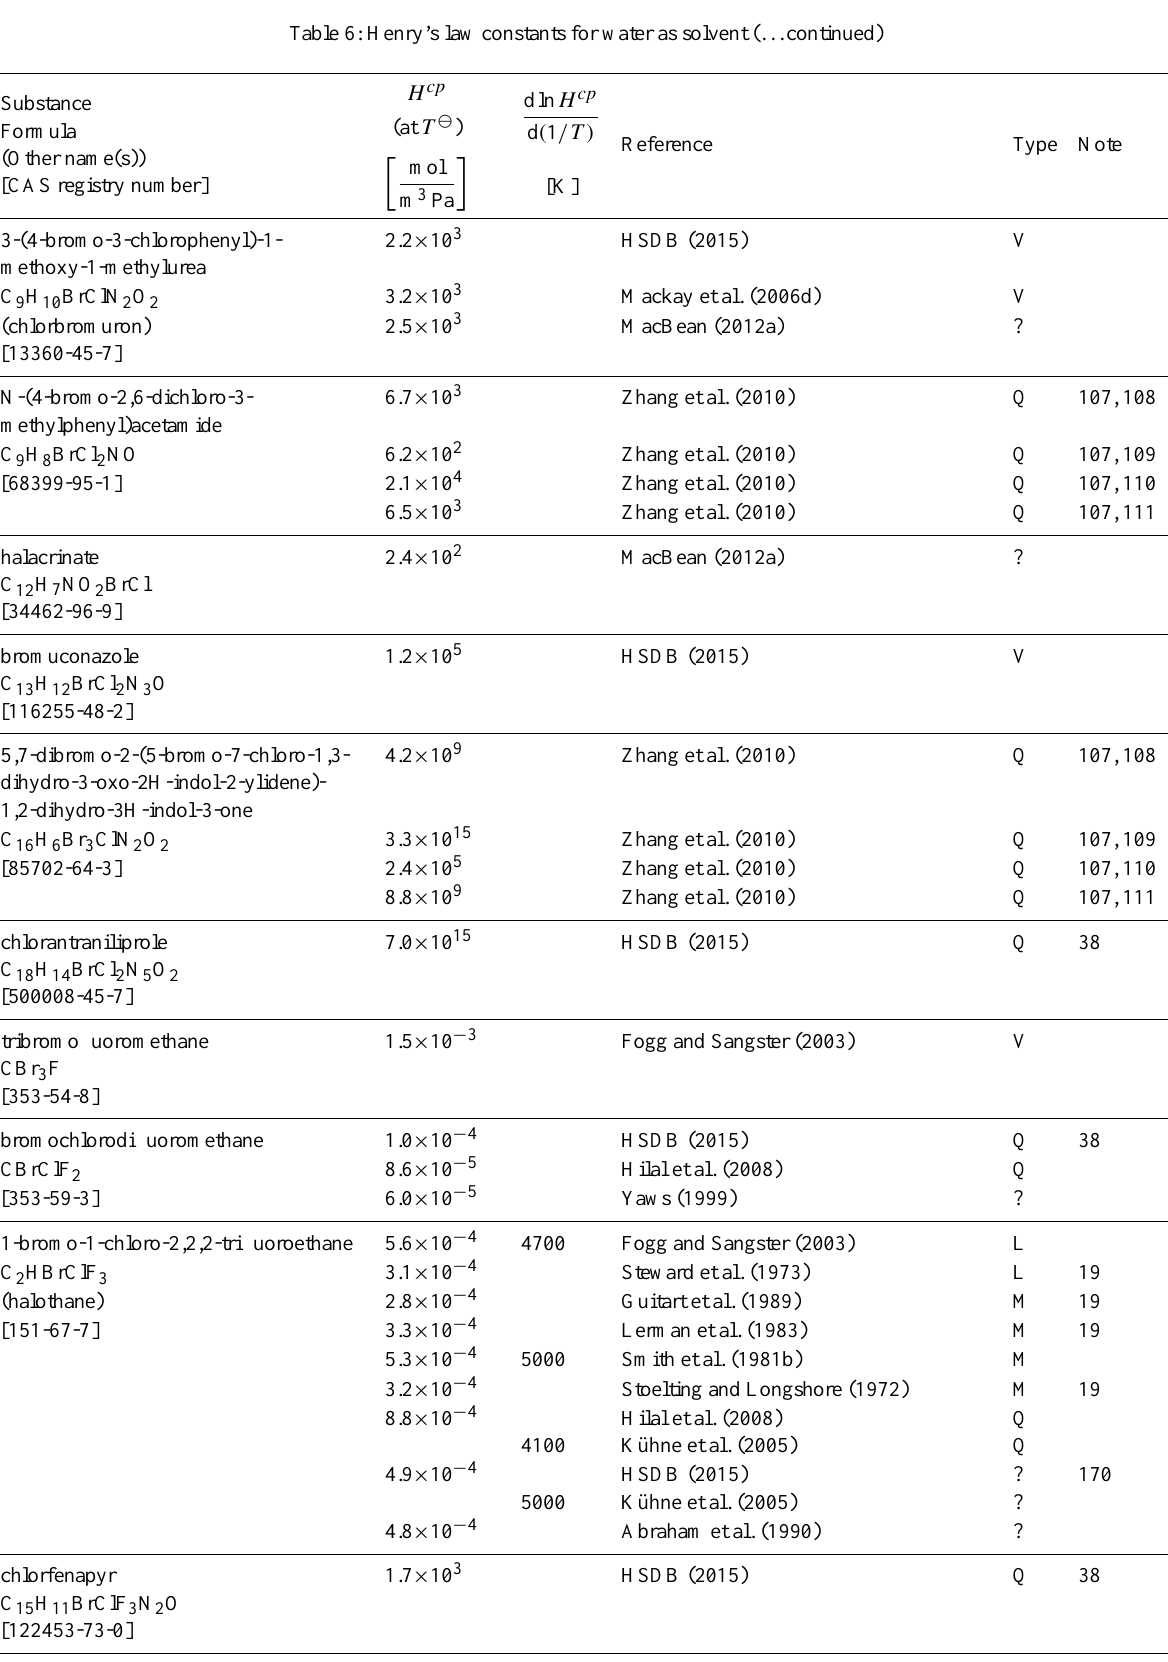
Table 6: Henry’s law constants for water as solvent